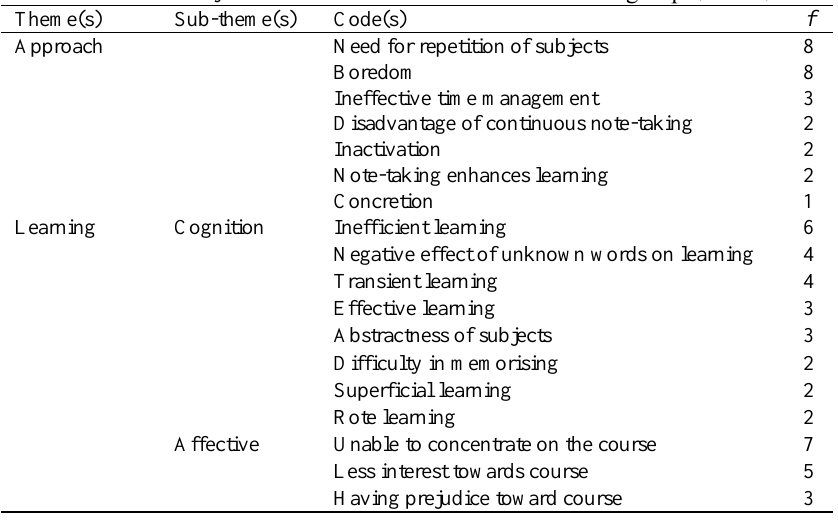
Table 5 Content analysis of the students’ interviews in TCbio group ( n = 10)